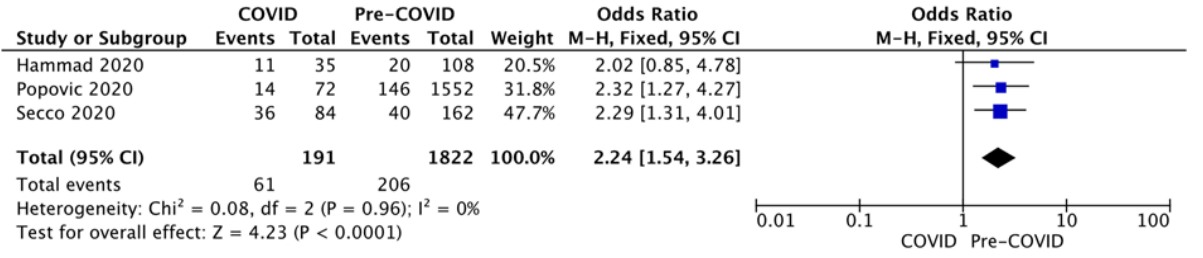
Figure 8. Forest plots for presentation delay >24 h. 3.3. STEMI Outcome In-hospital mortality was reported by eight studies with increased heterogeneity (I2 = 58%, p = 0.02) and the pooled effect did not reveal a significant increase. Overall, in- hospital mortality was 7.04% for STEMI patients presenting before the pandemic com- pared to 7.02% during the first months of the pandemic ( p = 0.97). The pooled effect is largely based on the mortality reported by three large multicentric studies [11,12,16] con- tributing to more than 80% of the total weight. The funnel plot did not reveal a significant bias (Figure 9). Figure 9. Forest plots for In-hospital mortality. 4. Discussion 4.1. Patients’ Profile This meta-analysis is the first to evaluate the impact of the first months of the COVID- 19 pandemic on the presentation and outcome of STEMI patients. Our results suggest that patients presenting with STEMI during the pandemic are younger and register a higher